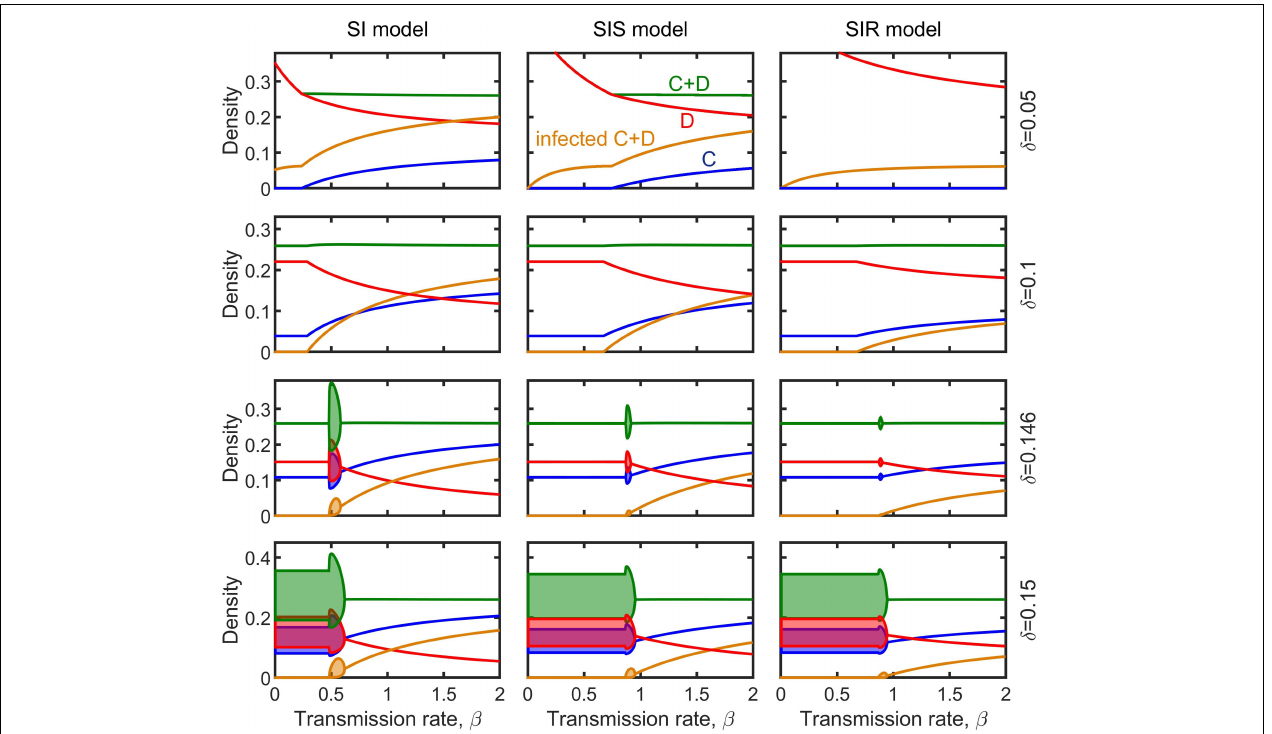
FIGURE 4 | Effect of transmission rate β on the evolution of cooperation in the model of SI (left column), SIS (middle column), and SIR (right column). Blue, red, brown, and green shadows represent the density range of cooperators, defectors, infectious individuals, and the whole population in periodic solution, respectively. Parameters are b = 1, c = 0 . 3, m = 0 . 1, ξ = 0 . 1, γ = 0 . 1, and κ = 0 .